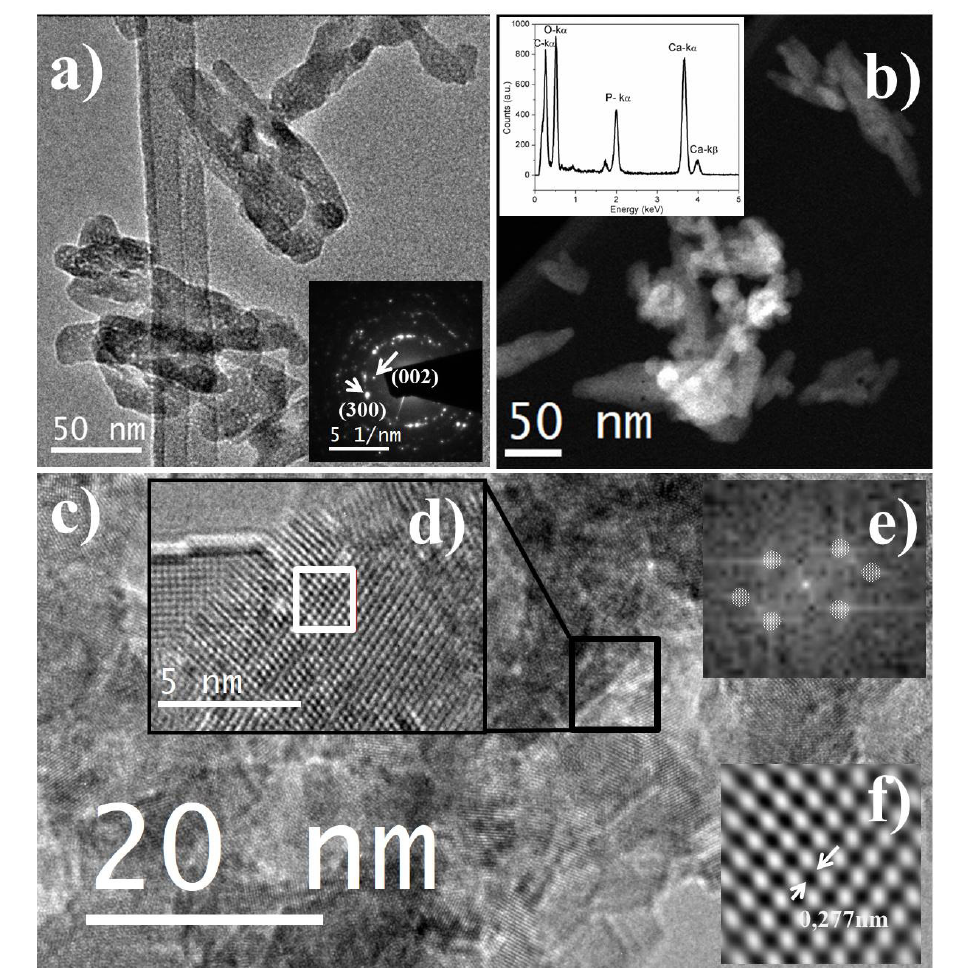
Figure 7. MET bright field image and diffraction pattern (a), HAADF - STEM image and EDXS (b), MET bright field image (c), HRTEM (d), FTT (e) and IFFT (f) of the HAp-600